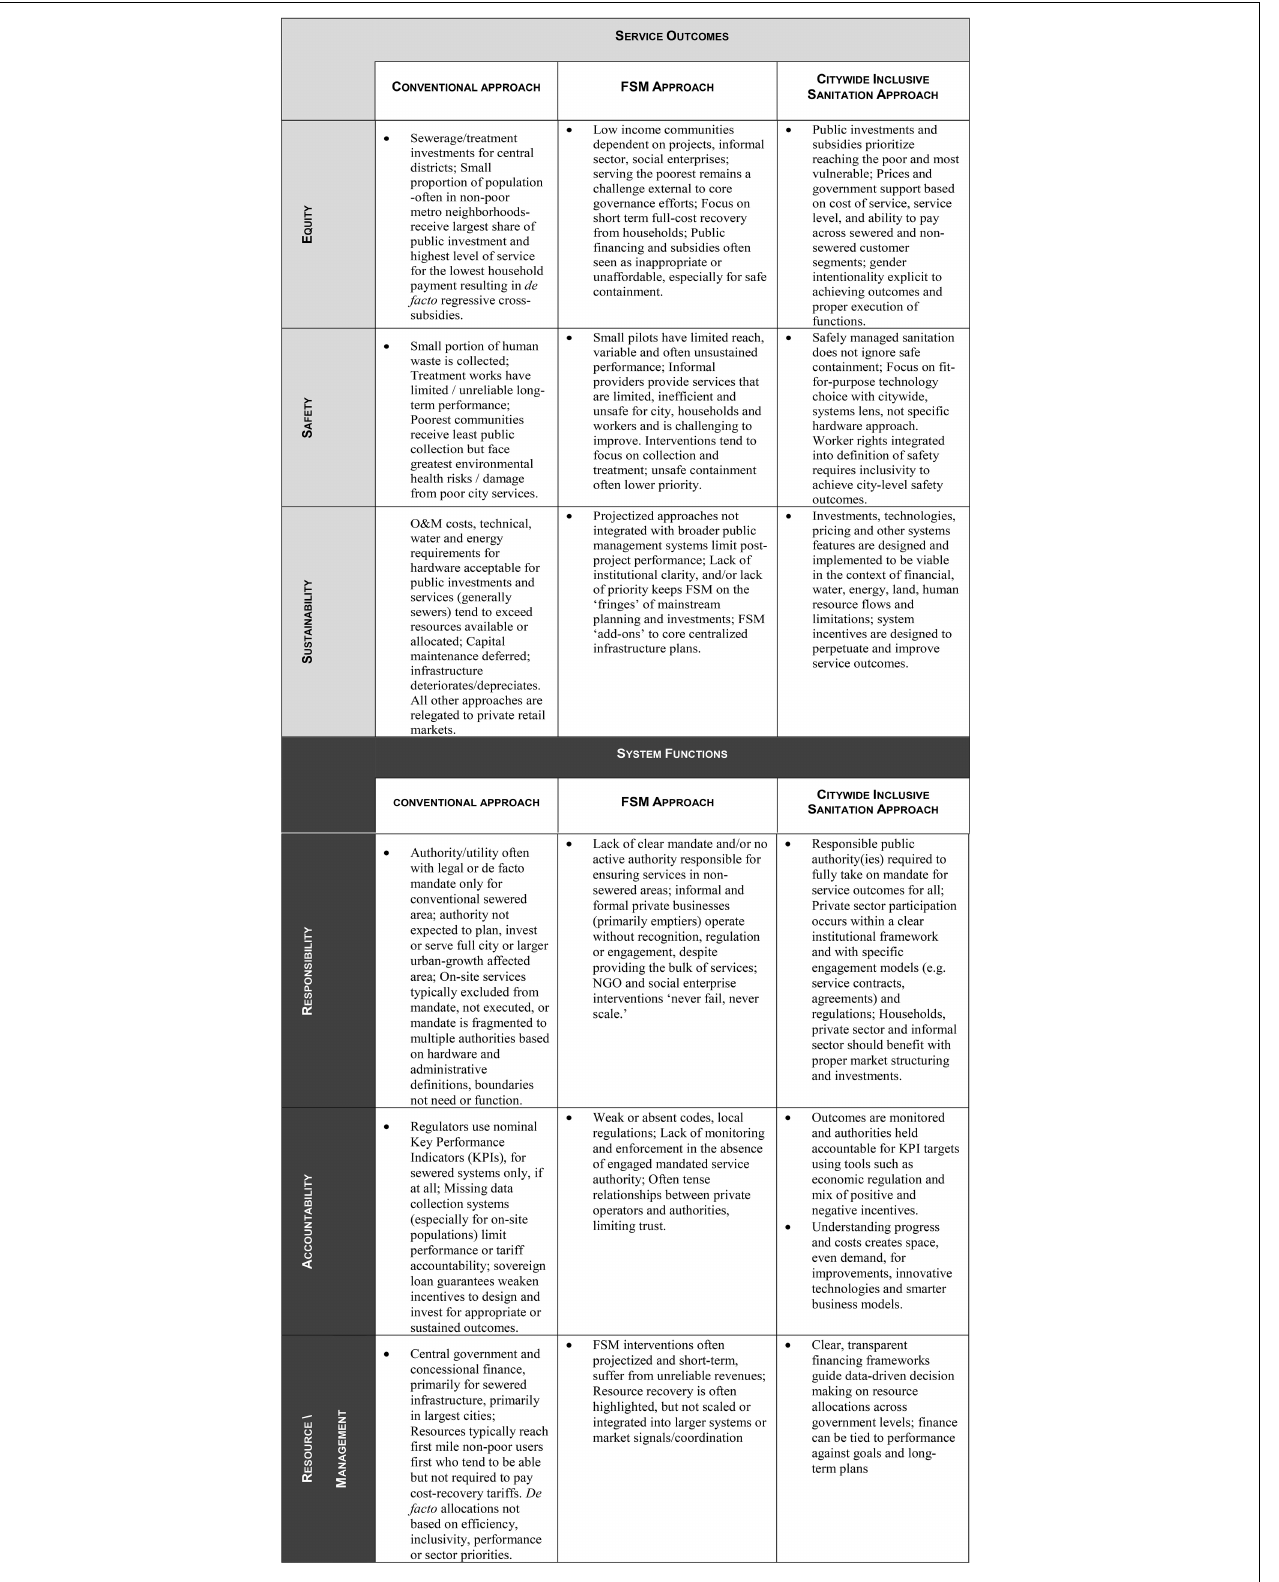
FIGURE 3 | Comparing CWIS to conventional and FSM approaches.